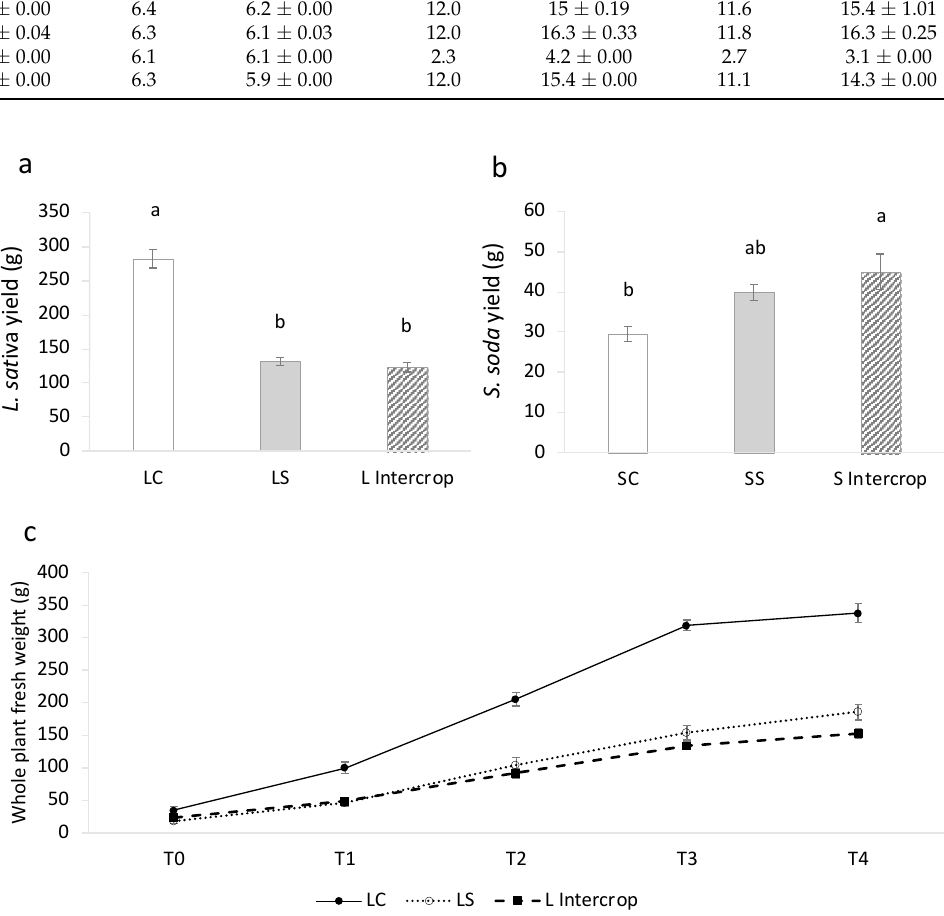
Figure 1. Edible L. sativa ( a ) and S. soda ( b ) yield expressed as the average shoot fresh weight and weekly whole plant fresh weights ( c ) in grams. All data points are means ± SEM. Different lowercase letters indicate significant differences between treatment groups within the same species ( p < 0.05) based on one-way ANOVA.